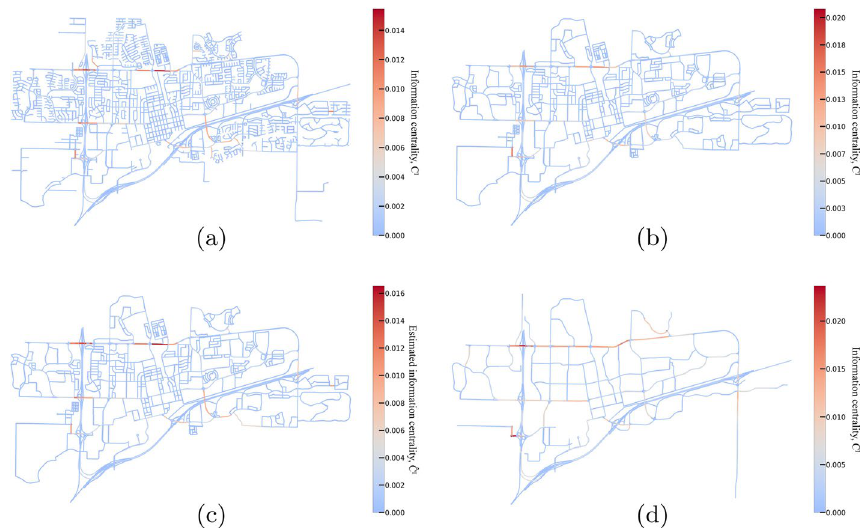
Fig. 5 C I distribution in Davis road network: a original, b proposed method, c proposed method with centrality estimation, and d simplified by omitting all residential roads